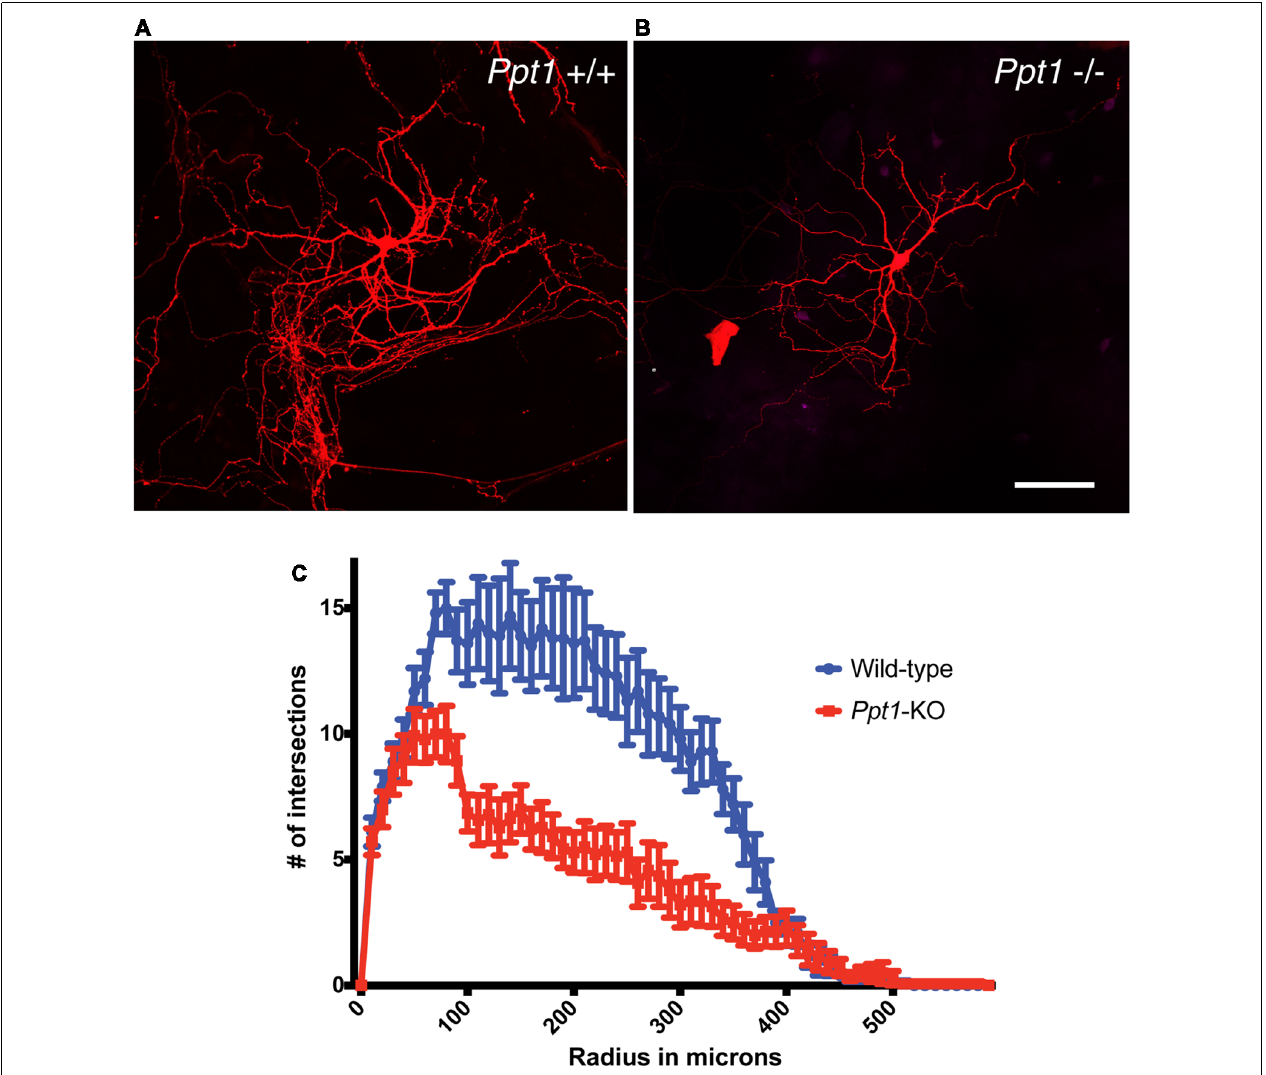
FIGURE 2 | Reduced complexity of cultured Ppt1 -/- hippocampal neurons. The number of dendrites crossing concentric rings with regular radial increments centered in the neuronal cell body (Sholl analysis) revealed a more simplified dendritic tree in cells lacking Ppt1 − / − (B,C) in comparison to cells derived from control littermates (A,C) . Calibration bar, 100 µ